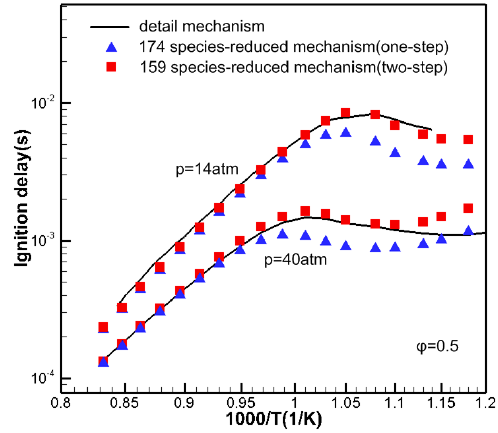
Figure 2. The ignition delay time of n-dodecane with detailed mechanism and reduced mechanisms by one-step and two-step direct relationship graph (DRG) method.